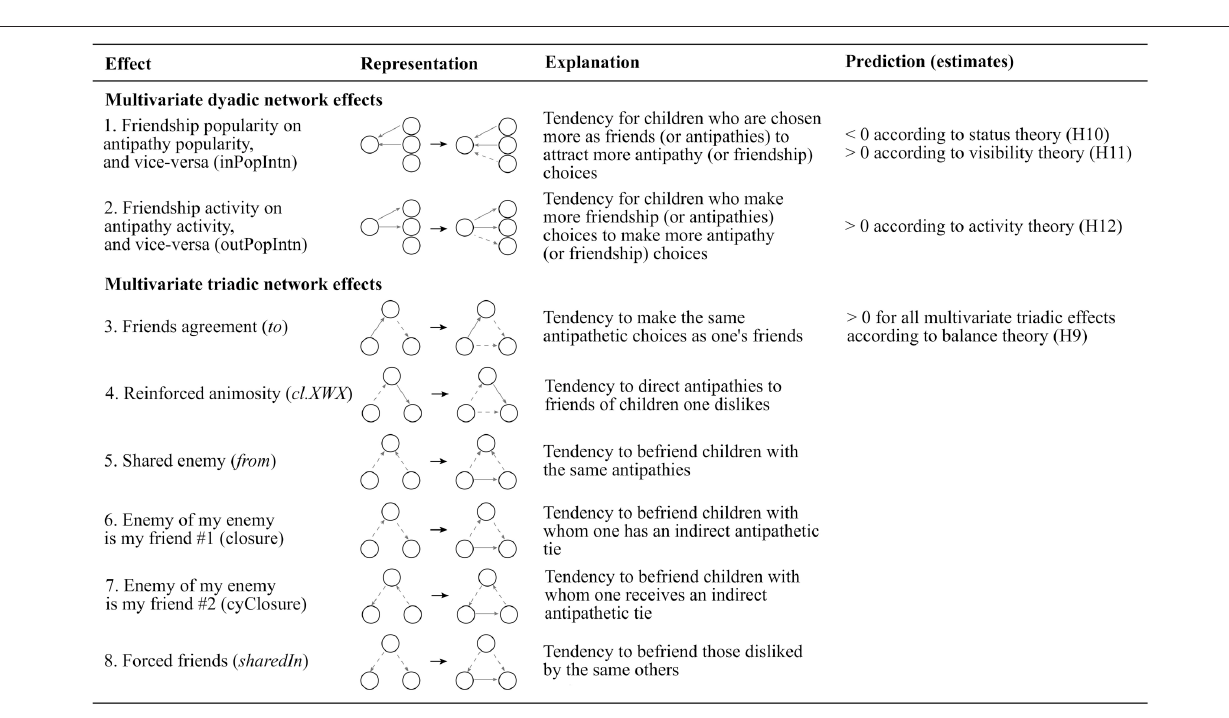
FIGURE 3 | Summary of SIENA multivariate effects. Solid lines represent friendship ties and dotted lines antipathy ties. If the predicted estimate is positive, the formation (or maintenance) of ties that create the corresponding representation are expected to occur; and the converse if the predicted estimate is negative. For detailed explanations concerning these predictions please see Section Multivariate